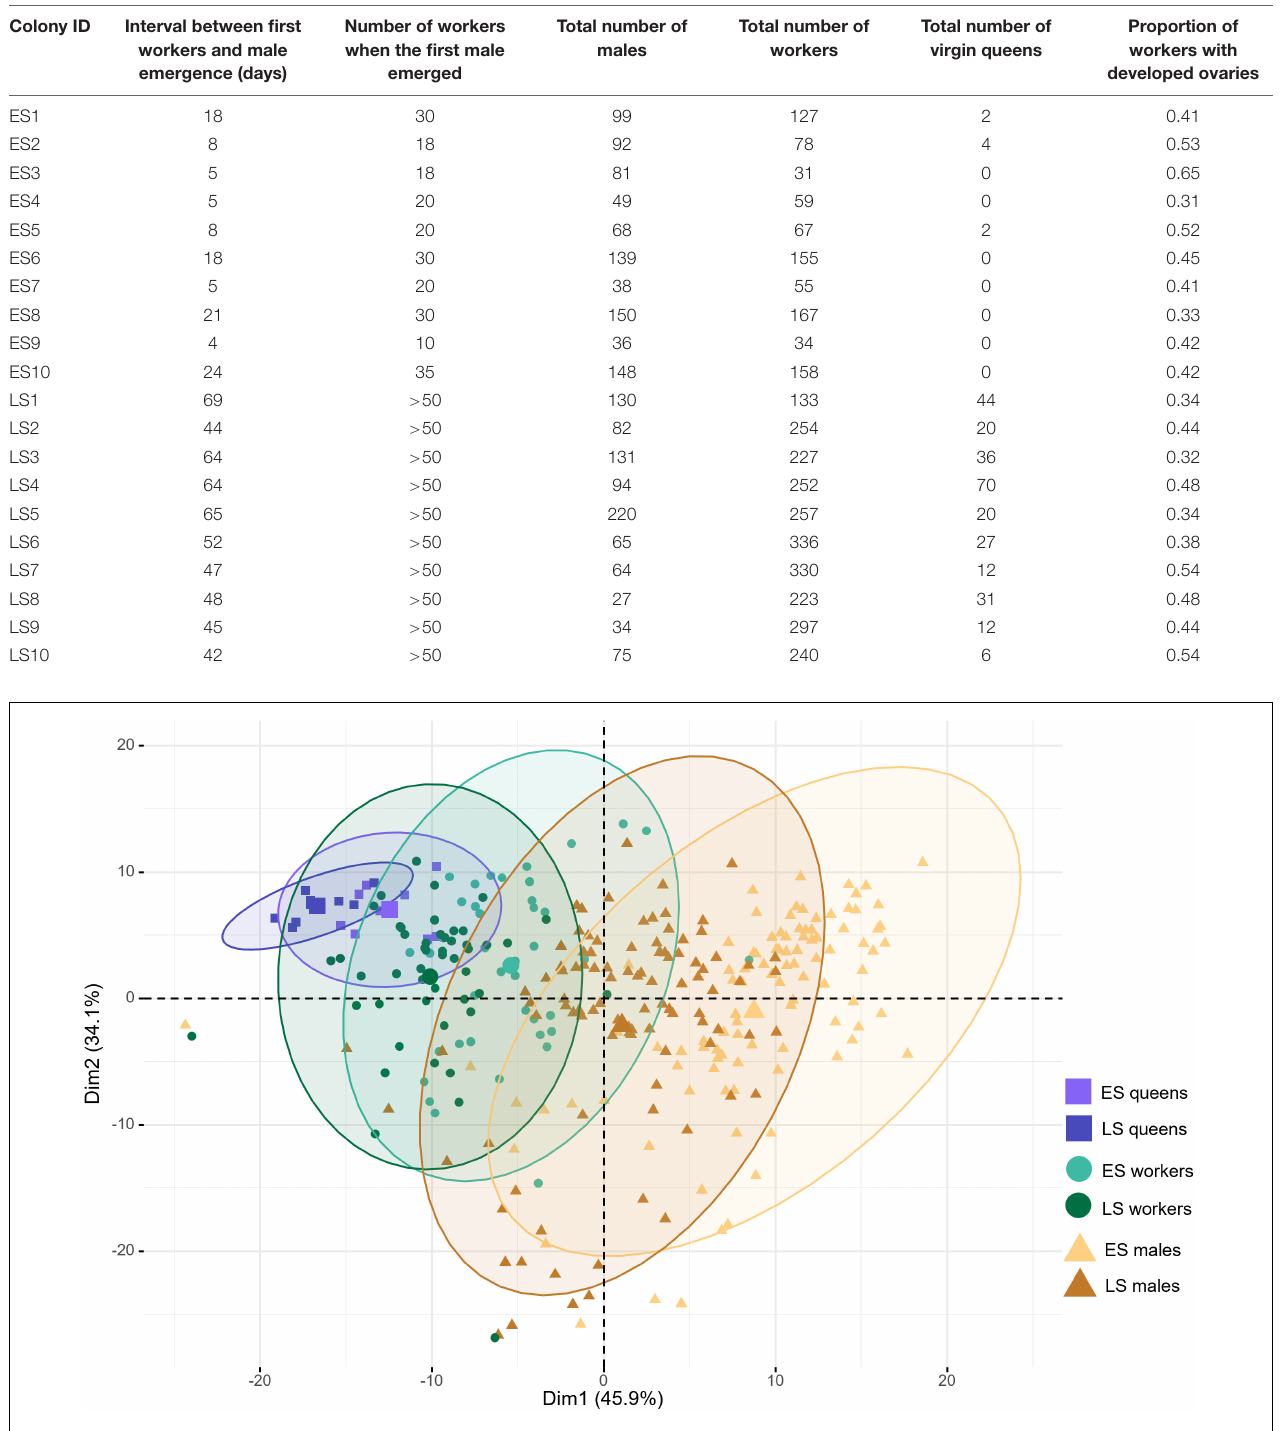
TABLE 1 | Detailed data on the twenty early switching (ES) and late switching (LS) colonies including the number of days between worker and male emergence, the total number of workers present in the colony when males were first observed and at the end of the experiment, the total number of virgin queens, as well as the proportion of workers with developed ovaries.